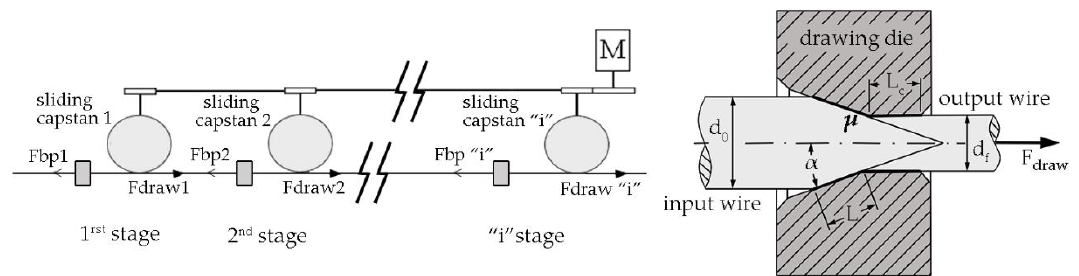
Figure 3. Sliding capstans system and wire-die interface in wiredrawing: input diameter ( d 0 ), output diameter ( d f ), semi-angle ( α ), friction coefficient ( μ ), bearing length ( L c ) and contact length ( L ).